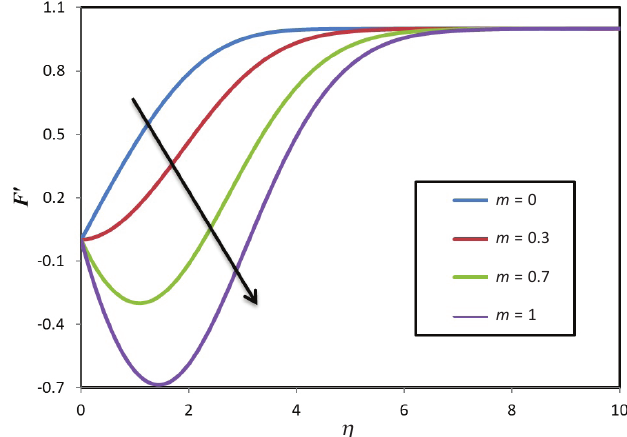
Fig. 6 – dF/d h (primary velocity) versus h for K = 0.5, I = 0.5, F = –0.5 (heat sink), Pr = 100 (weak polymers), Ec = 0.2, with m = 0 (Blasius flow), 0.3 (wedge), 0.7 (wedge), 1.0 (stag- nation flow)